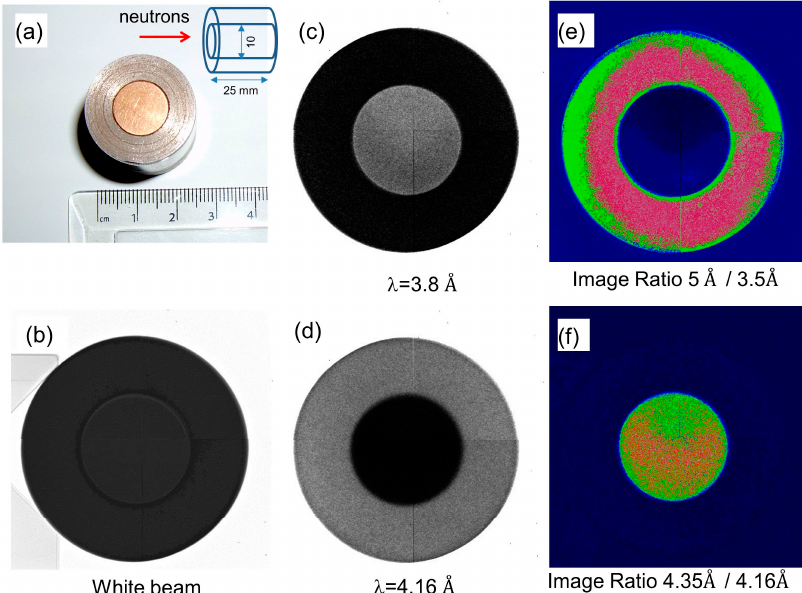
Figure 10. ( a ) Photo and sketch of the FeCu test object; ( b ) normalized white-beam radiography; ( c , d ) Fe and Cu enhancement by selecting suitable wavelengths; ( e , f ) Fe and Cu enhancement by producing image ratios from suitable wavelength ranges.